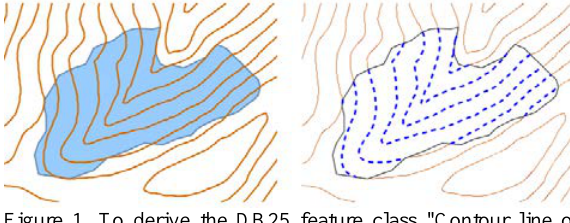
Figure 1. To derive the DB25 feature class "Contour line on glacier" it was necessary to perform a spatial query between the contour lines and the glacier feature